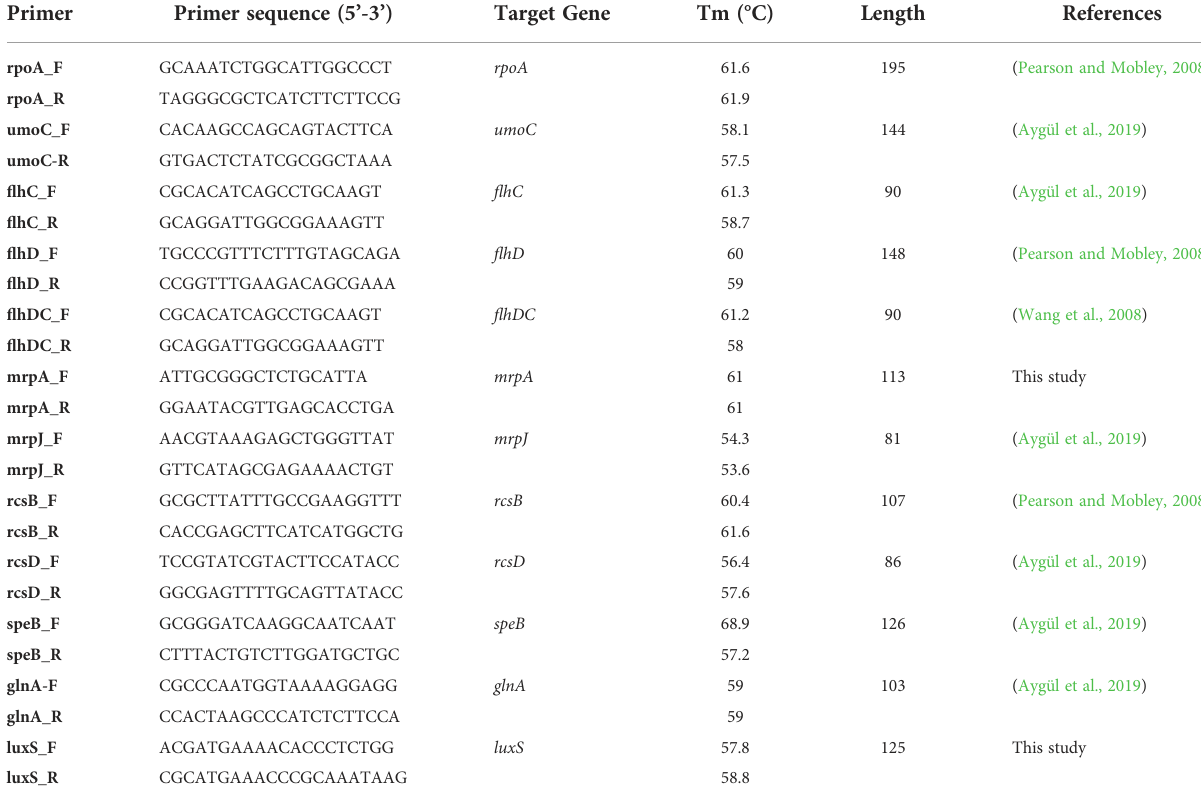
TABLE 1 List of primers used in quantitative PCR